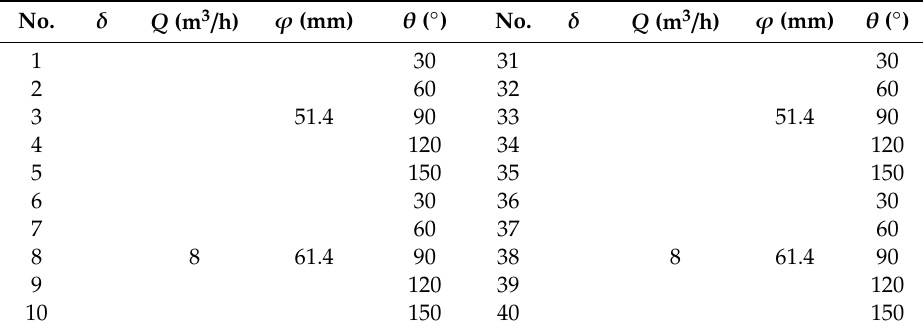
Table 1. Working conditions of the proposed